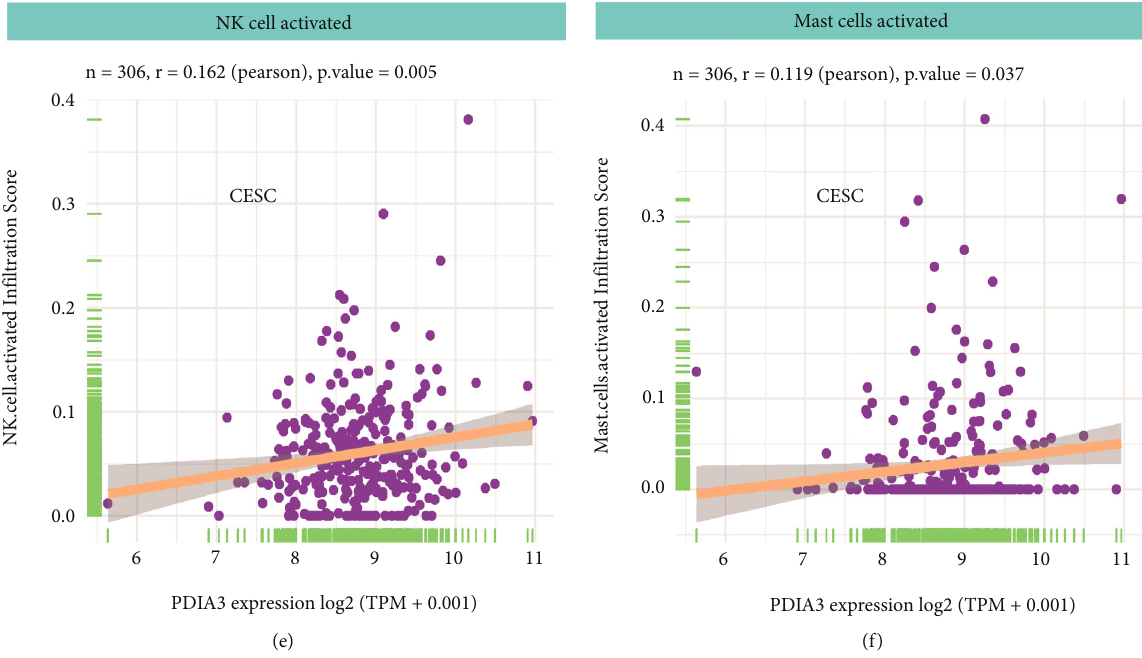
Figure 7: (a) Relationship between the PDIA3 expression and B cell memory in cervical cancer. (b) Relationship between the PDIA3 expression and T cell regulatory in cervical cancer. (c) Relationship between the PDIA3 expression and monocytes in cervical cancer. (d) Relationship between the PDIA3 expression and macrophages M2 in cervical cancer. (e) Relationship between the PDIA3 expression and NK cell activated in cervical cancer. (f) Relationship between the PDIA3 expression and mast cells activated in cervical